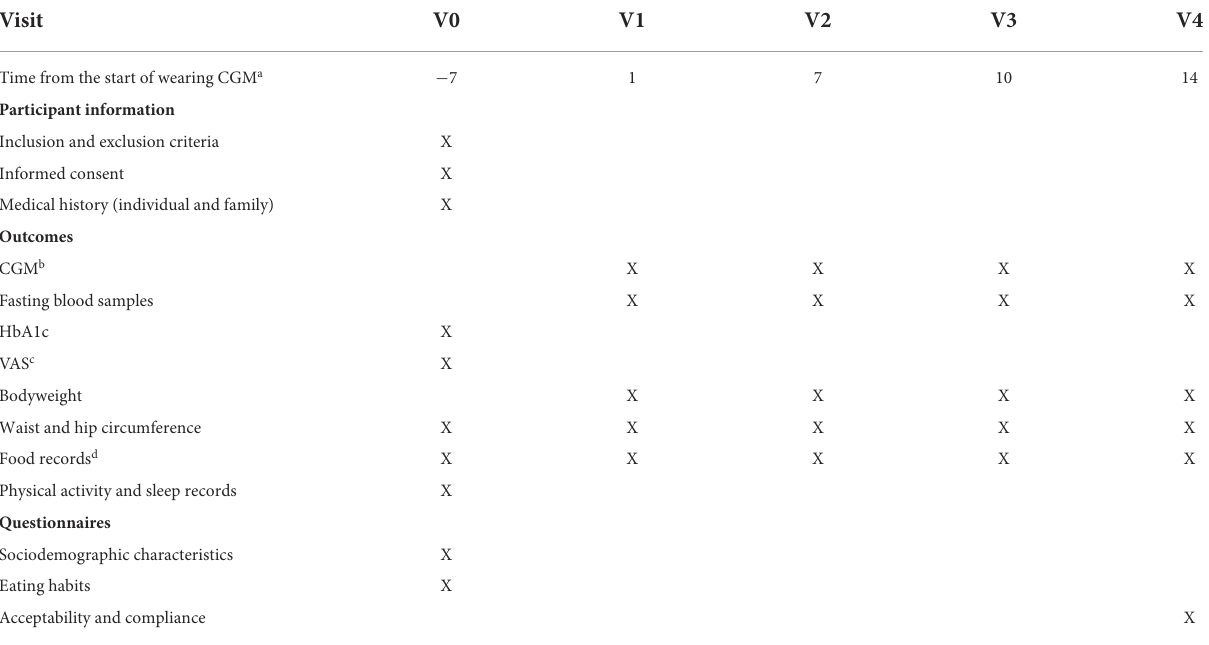
TABLE 2 Overview of study visits.